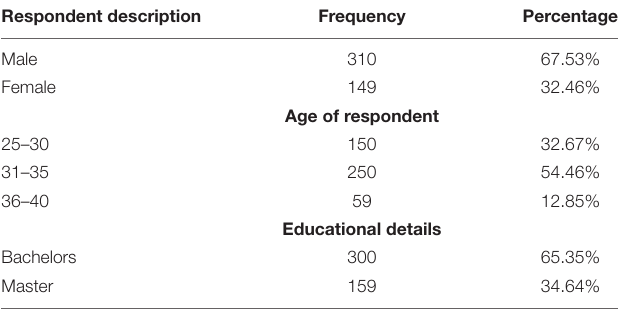
TABLE 2 | Mean scores (M), standard deviations, values of Kurtosis, and